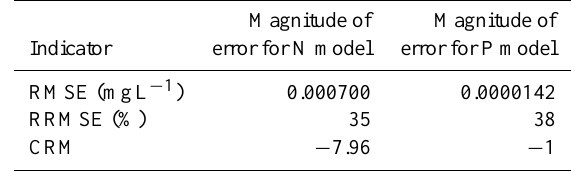
Table 4. Model performance.